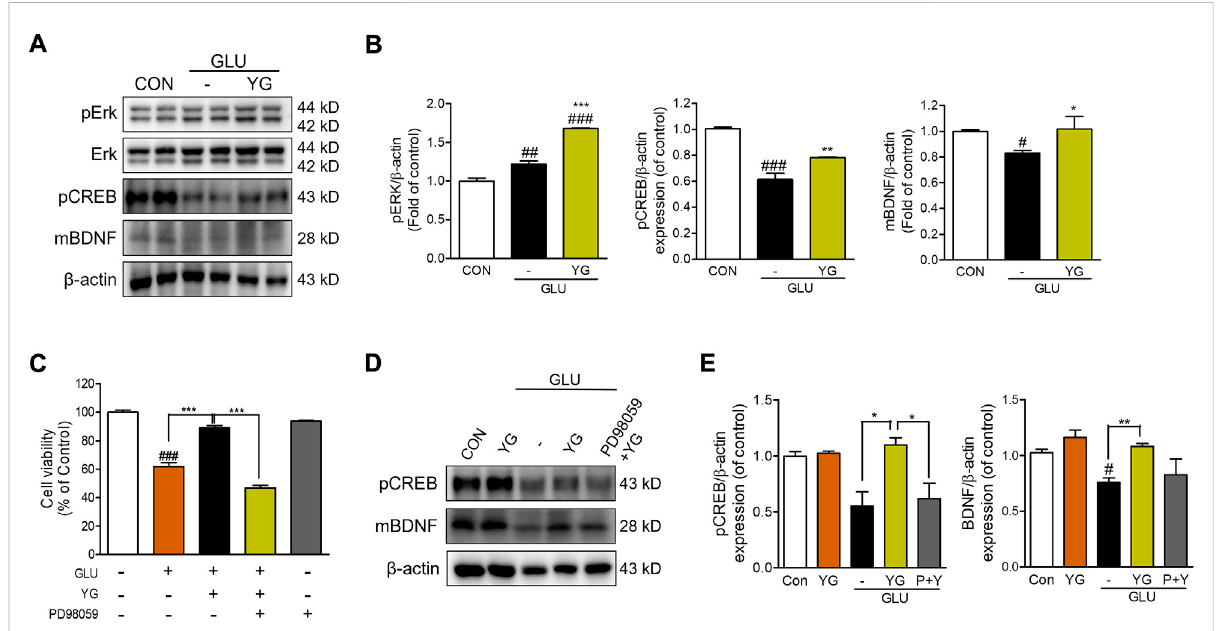
FIGURE 4 YG regulates ERK, CREB and BDNF activation in glutamate-induced cytotoxicity in HT22 cells. (A) Western blot band and (B) its histogram for pERK, pCREB and mBDNF. (C) Cell viability of ERK inhibitor, PD98059 with YG treatment. (D) Western blot band and (E) its histogram for pCREB and mBDNF in glutamate-induced cells treated YG and/or PD98059 (10 μ M). All data are presented as the mean ± SEM from three independent experiments. # p < 0.05, ## p < 0.01, ### p < 0.001 vs. CON; * p < 0.05, ** p < 0.01, *** p < 0.001 vs. GLU. CON; control, GLU; glutamate 5mM,